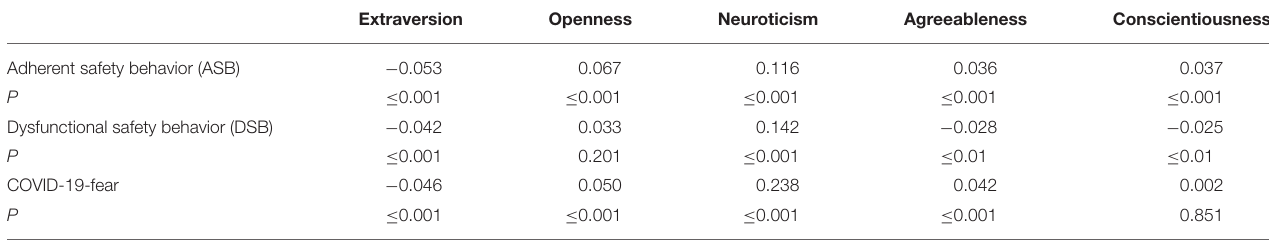
TABLE 3 | Spearman’s rho correlation between the scales of adherent safety behavior (ASB), dysfunctional safety behavior (DSB), and COVID-19-fear and personality traits.